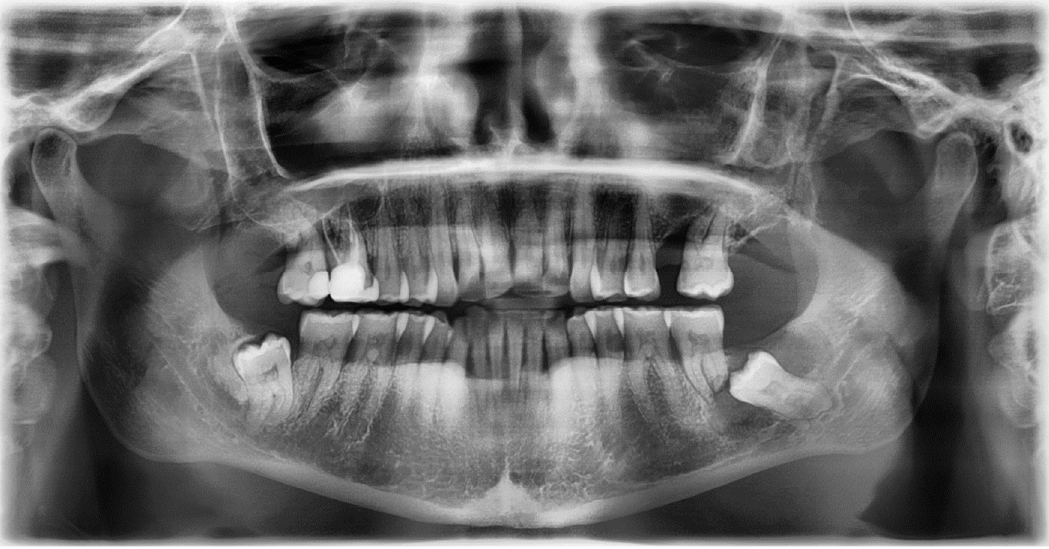
Figure 8. Panoramic X-ray of case #3.